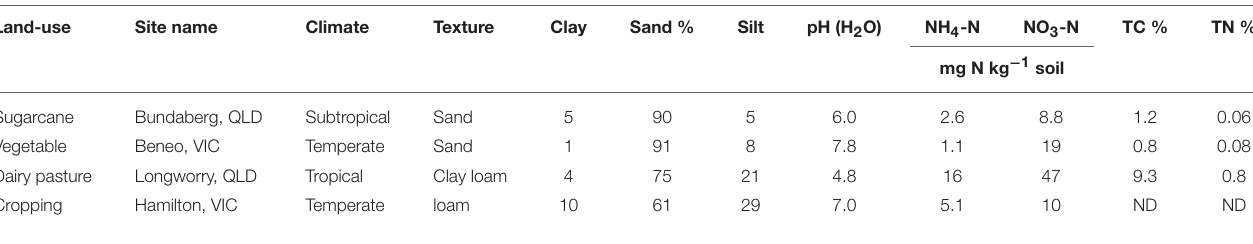
TABLE 1 | Field site description and basic characteristics of soils used in this study.